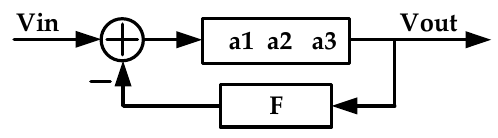
Figure A1. Harmonic distortion in negative feedback.